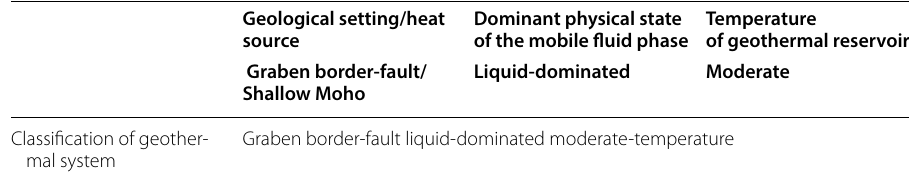
Table 1 Example of the geothermal system classification for